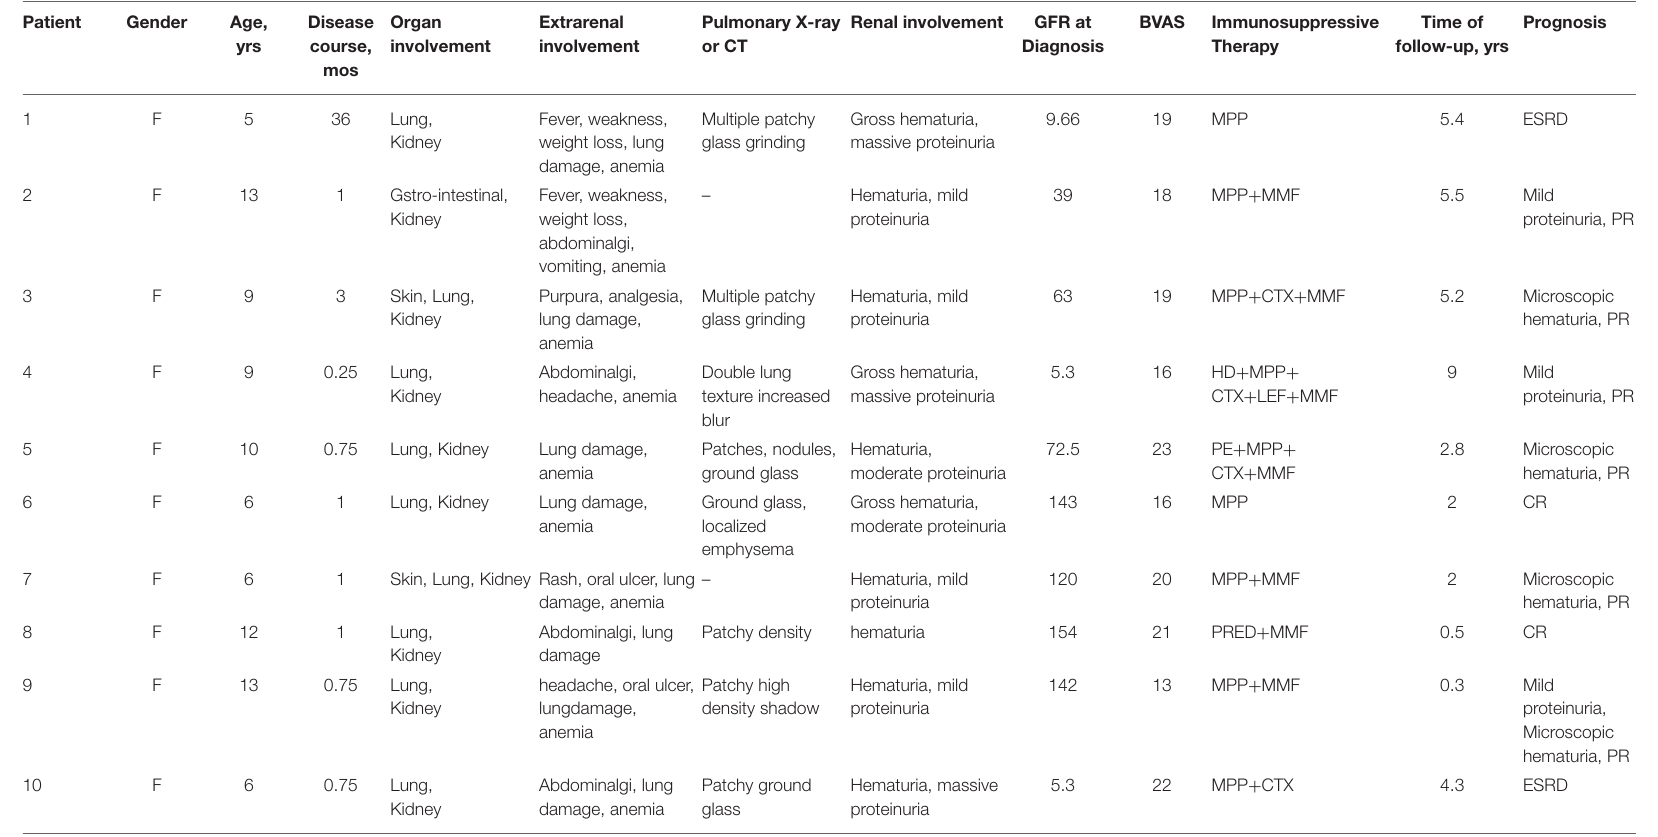
BVAS, birmingham vasculitis activity score (at time of diagnosis); HD, hemodialysis; PE, plasma exchange; PRED, prednisone; MPP, methylprednisolone impact; CTX, cyclophosphamide; LEF, leflunomide; MMF, mycophenolate mofetil; ESRD, end stage renal disease; PR, partial